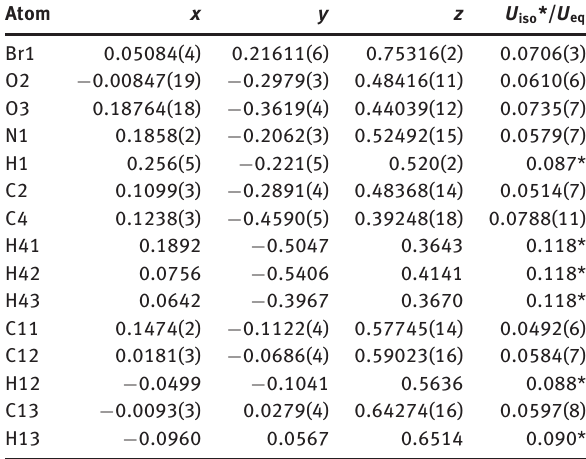
Table 2: Fractional atomic coordinates and isotropic or equivalent isotropic displacement parameters (Å 2